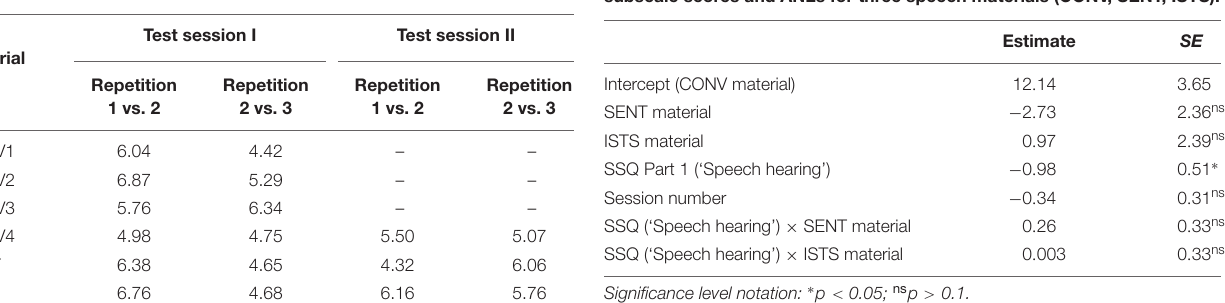
TABLE 7 | Model testing for differential associations between SSQ subscale scores and ANLs for three speech materials (CONV, SENT,